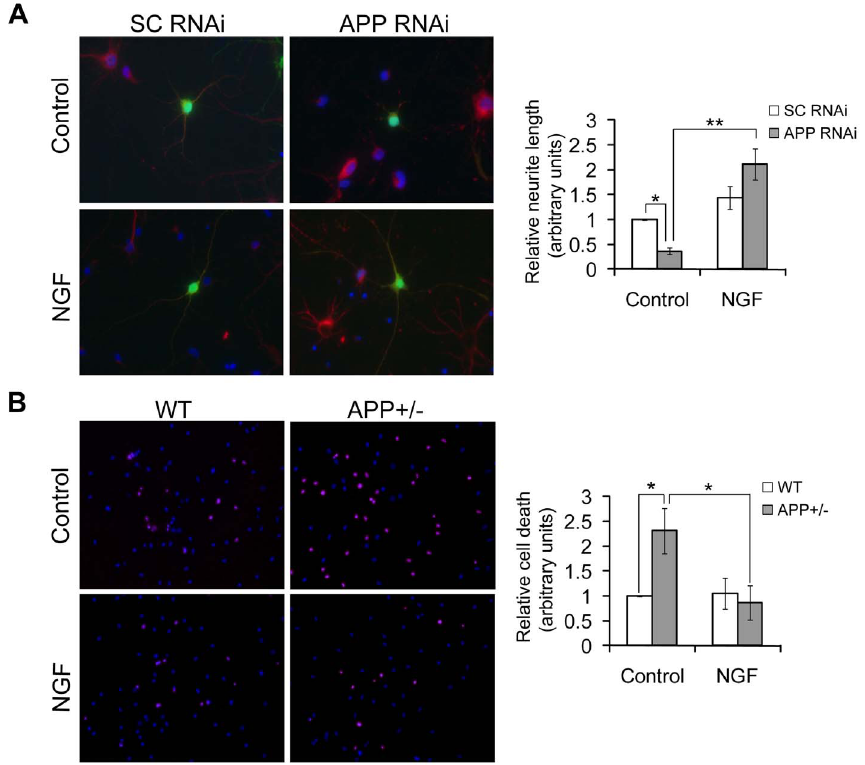
Figure 3. APP deficiency impairs neurite outgrowth and neuronal survival at basal levels, but promotes neurite outgrowth and neuronal survival more acutely upon NGF stimulation. (A) The day after plating embryonic day 17 rat primary neurons, neurons were infected with APP or scrambled control (SC) RNAi-containing lentivirus for 1 d. These neurons were then treated with or without 100 ng/mL NGF for 5 d, fixed, permeablized, immunostained with MAP2 antibody and a fluorescent-labeled secondary antibody, and observed under a fluorescent microscope. Infected cells were indicated by GFP fluorescence (in green) and neurons were indicated by positive MAP2 stainining (in red). The neurite lengths of infected neurons ( . 100) were measured for comparison. (B) Primary neurons from postnatal day 0 wild type (WT) and APP heterozygous ( + / 2 ) mice were treated with or without 100 ng/mL NGF for 5 d. These neurons were then treated with 25 m M A b for 1 d. After staining with propidium iodide (in red) and DAPI (in blue), the numbers of dead neurons ( . 300) were counted for comparison. Controls were set as one arbitrary unit. Error bars indicate SEM. *: P , 0.05, **: P , 0.01.